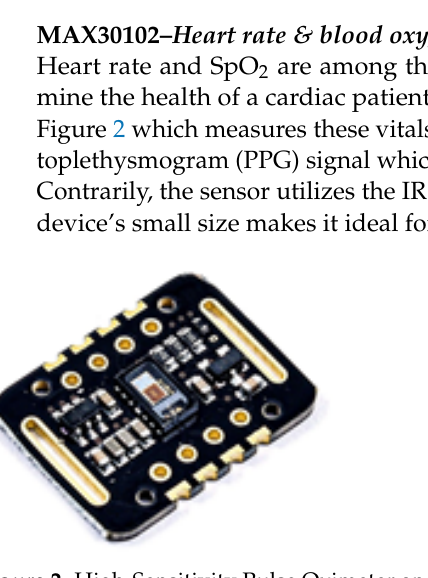
Figure 2. High-Sensitivity Pulse Oximeter and Heart-Rate Sensor.